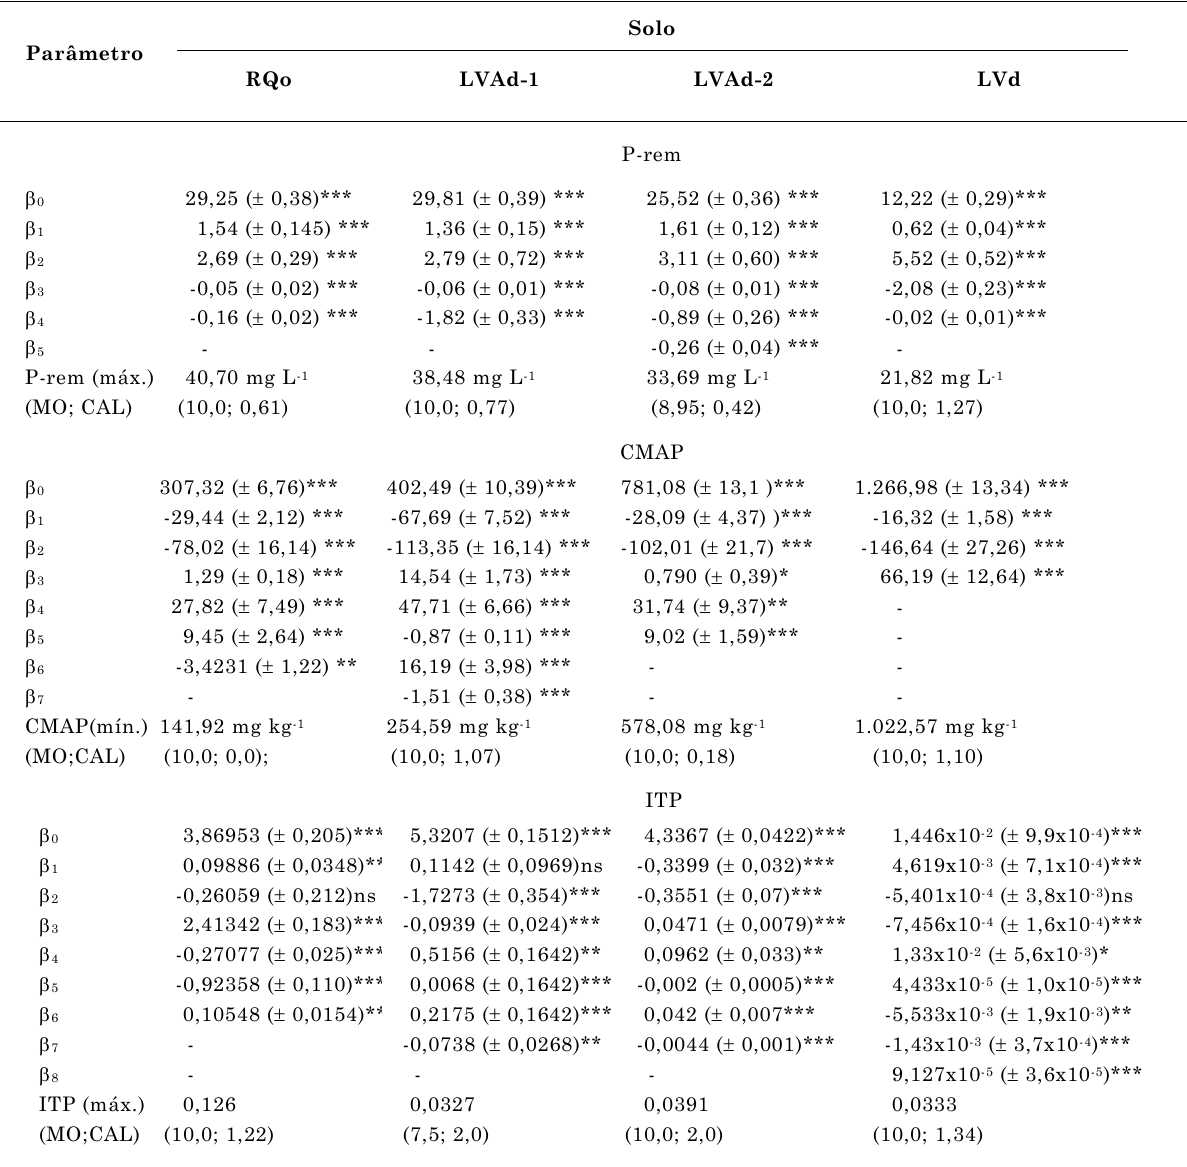
Quadro 3. Estimativa e significância dos parâmetros dos modelos apresentados no quadro 2, e valores máximos de fósforo remanescente (P-rem) e do índice tampão de fósforo (ITP) e mínimo de capacidade máxima de adsorção de fósforo (CMAP) e respectivas quantidades ideais de esterco bovino (MO) e calcário (CAL), em cada